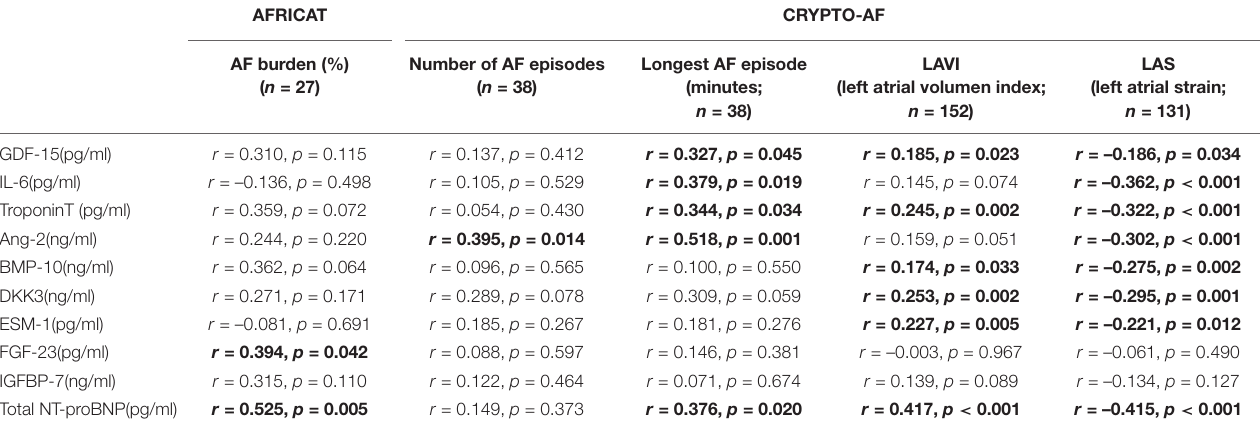
FIGURE 2 | Boxplot distribution of the biomarker circulating levels in the CRYPTO-AF and the AFRICAT cohort. Boxes extend from the 25th to 75th percentiles. The line in the middle is plotted as the median. Whiskers are drawn according to Tukey methodology ( ± 1.5 IQR) and larger values are plotted as individual points. Significant comparisons are indicated with an asterisk. TABLE 2 | Correlations between biomarkers and measures of AF burden and left atrial